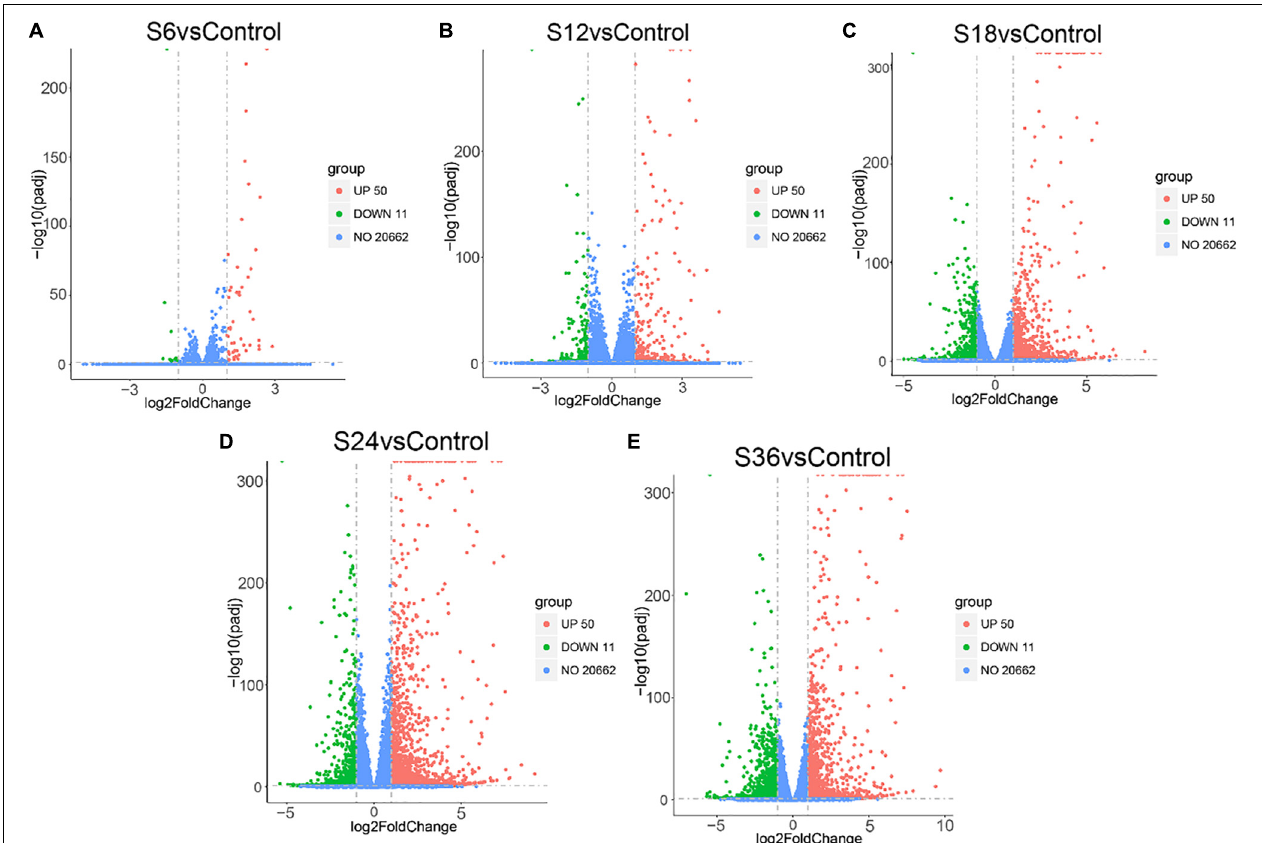
FIGURE 1 | Volcano plots of the DEGs in five comparison groups. Red indicates up-regulated DEGs, green indicates down-regulated DEGs, and blue indicates unchanged DEGs. (A) S6 vs. Control. (B) S12 vs. Control. (C) S18 vs. Control. (D) S24 vs. Control. (E) S36 vs. Control. Control: PK-15 cells at 0 h